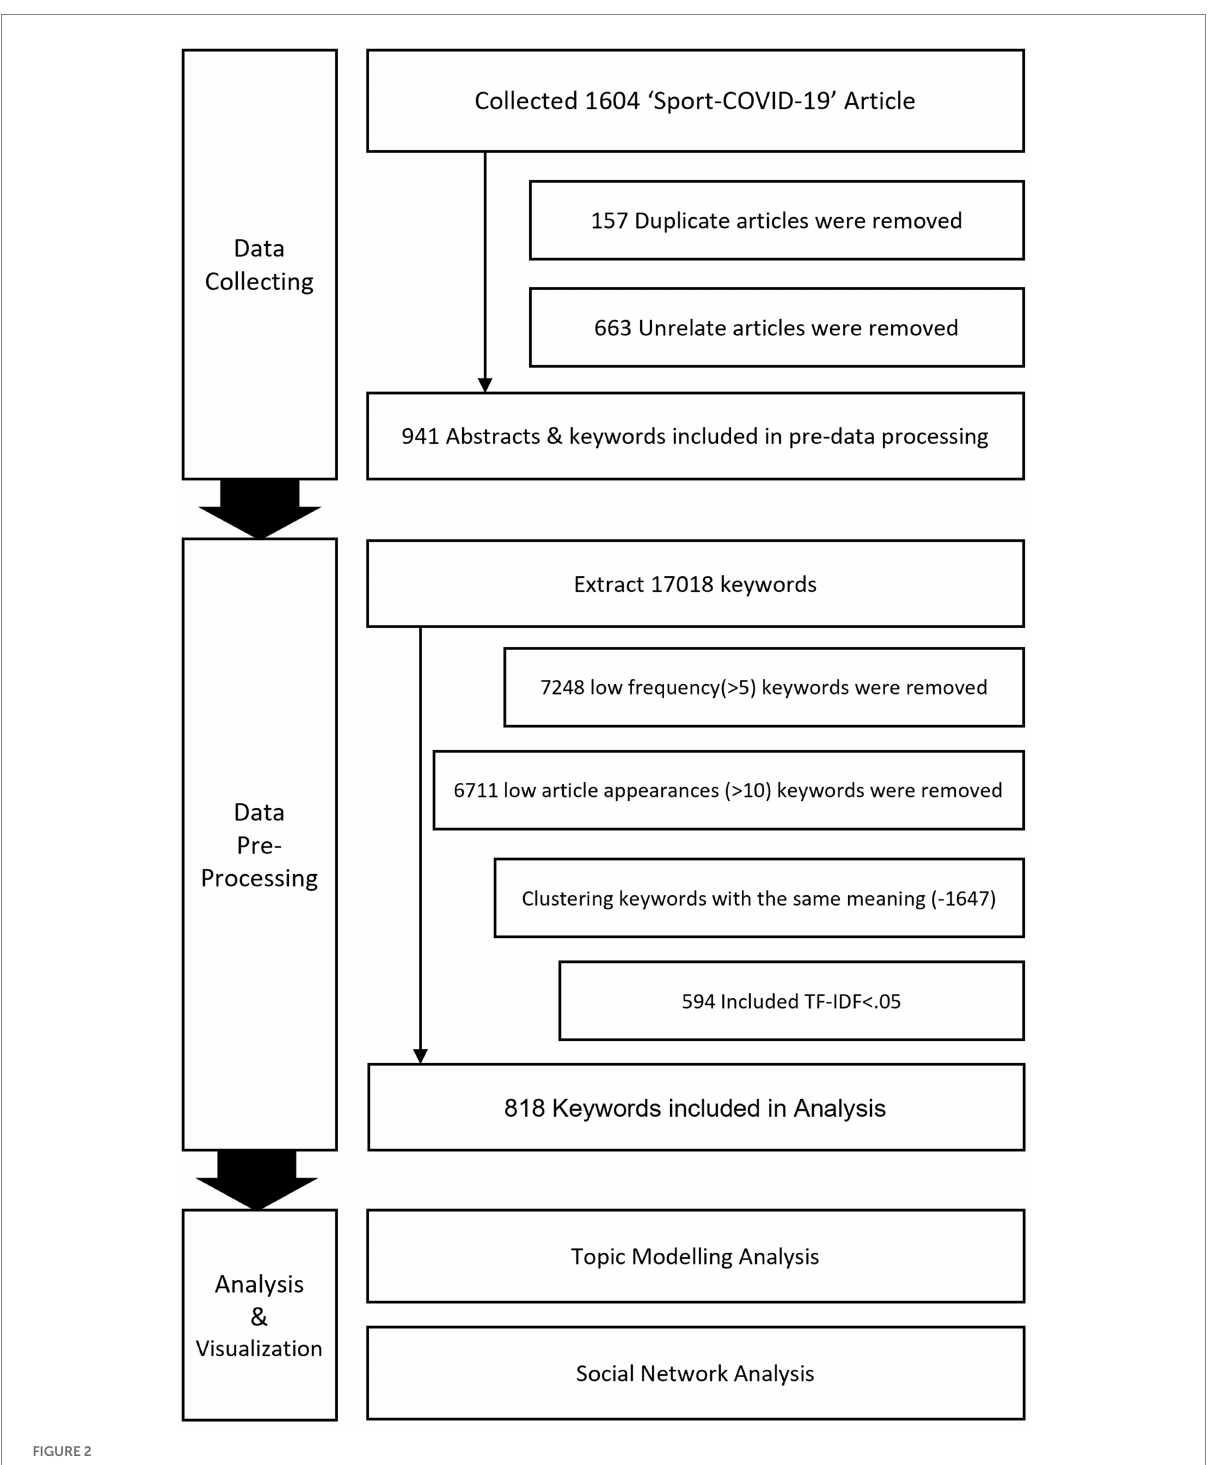
FIGURE 2 Research